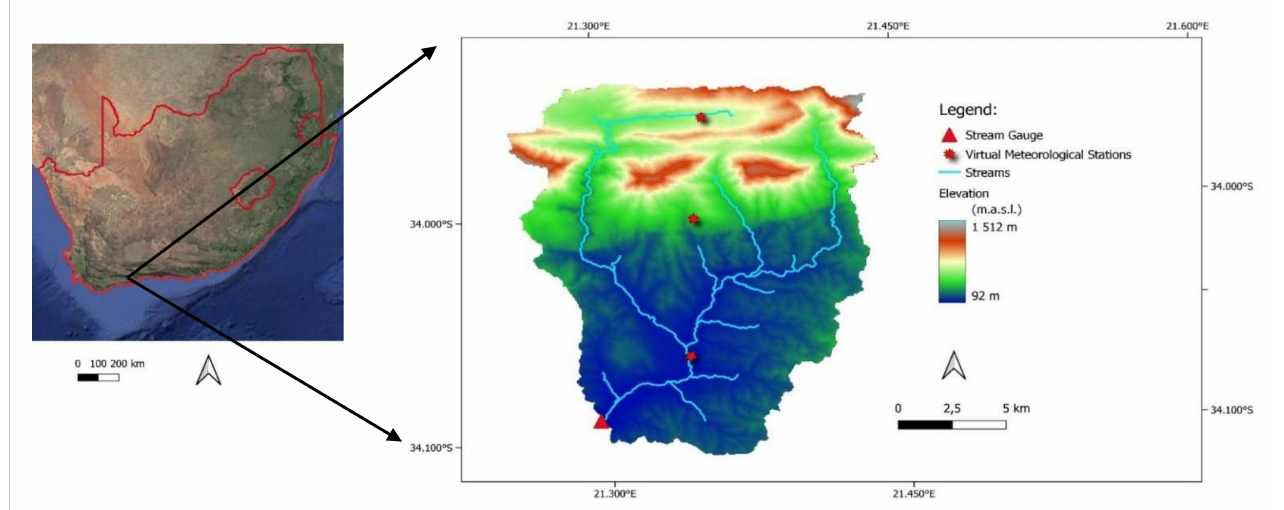
Figure 1. Map of the study area indicating streams, the stream gauge, and positions of virtual meteorological stations.